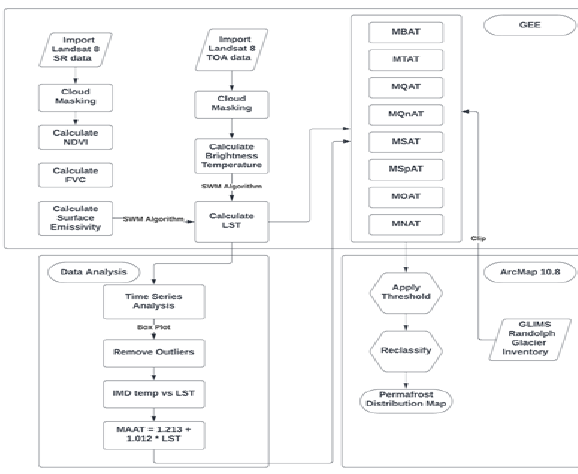
Figure 2: The flow chart showing the process of obtaining the Permafrost distribution map of Parvati Valley from 2013 to 2021.